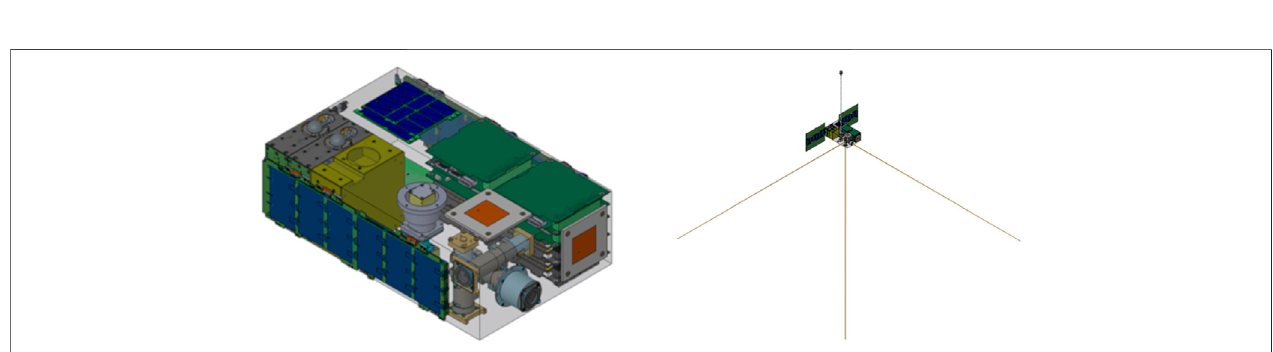
FIGURE5| A “ strawman ” probe6U Cubesat withstacer antennas, solarpanels, and aplaceholder magnetometer(left) stowedand (right)deployed.Note that the two images are shown at different scales.